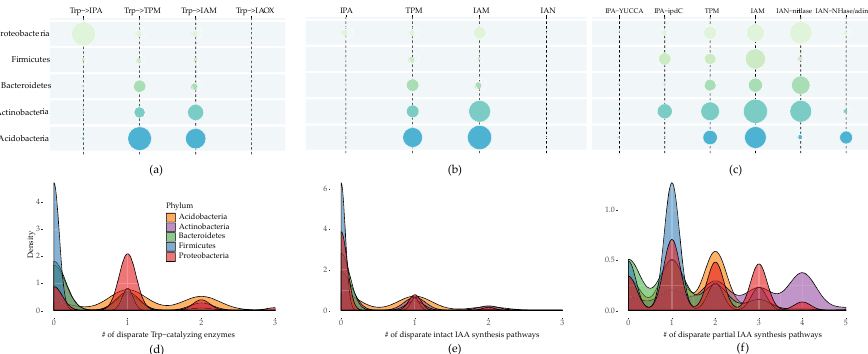
Figure 2. The distribution of IAA synthesis pathways across distinct phylum. The size of bubbles in each bubble plot represents the percentages of detected genomes in each phylum. ( a ) The number of genomes possessing the Trp-catalyzing enzymes. ( b ) The number of genomes potentially capable of de novo synthesizing IAA from Trp. ( c ) The number of genomes potentially competent to synthesize IAA from intermediates. The density plots ( d – f ) show the distribution of the number of genomes possessing coexisting pathways. The x axes represent the number of coexisting disparate synthesis pathways in an individual genome and y axes represent the density of the number of